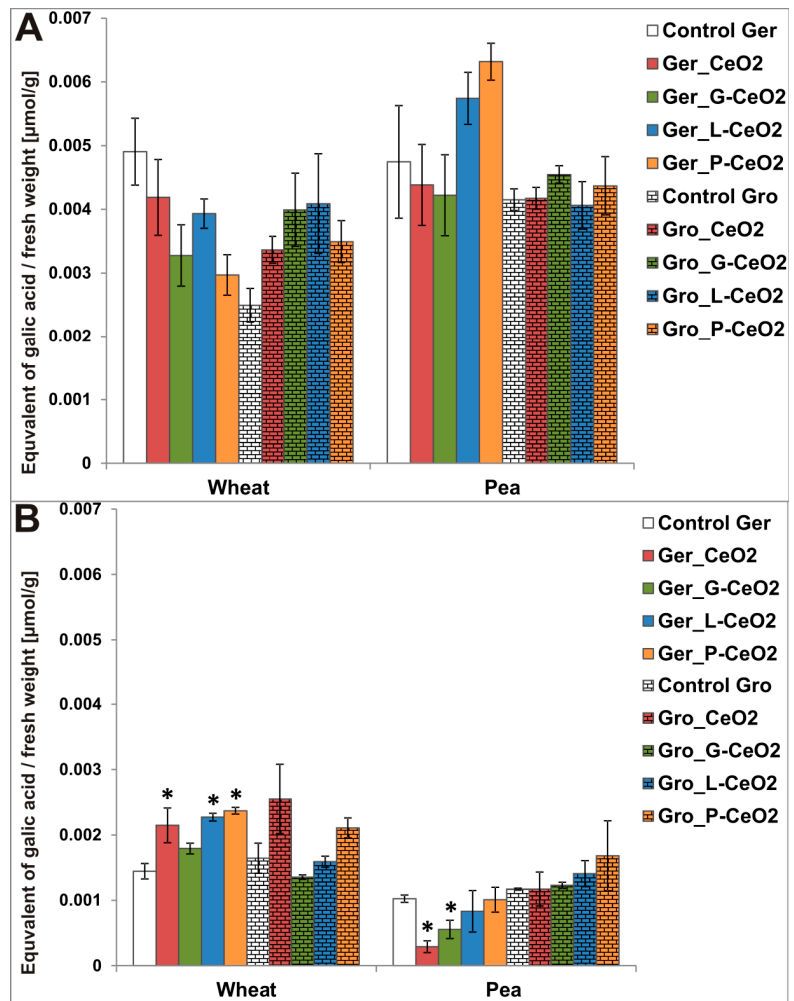
Figure 6. Total phenolic content (TPC) in shoots ( A ) and roots ( B ) of wheat and pea after Ger and Gro treatment with different nCeO 2 . Values are shown as mean ± SE; * indicates statistically significant differences in comparison with the corresponding control, p < 0.05.